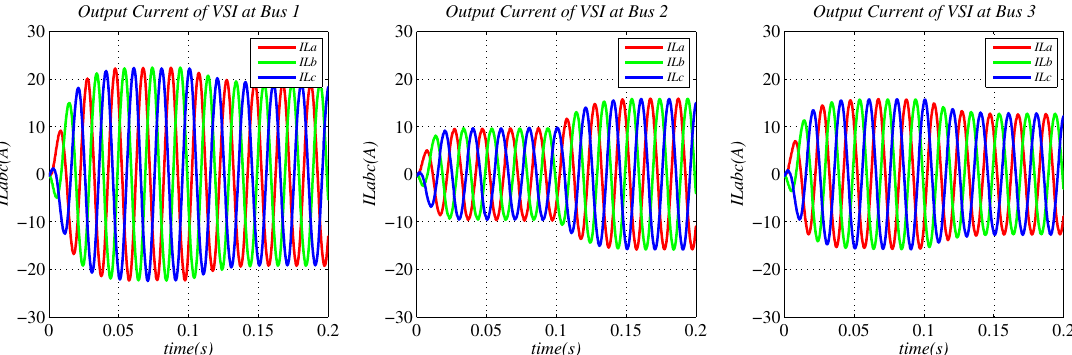
Figure 16. Output current of the VSI at Buses 1, 2, and 3 with the nonlinear load in the abc refer- ence frame.